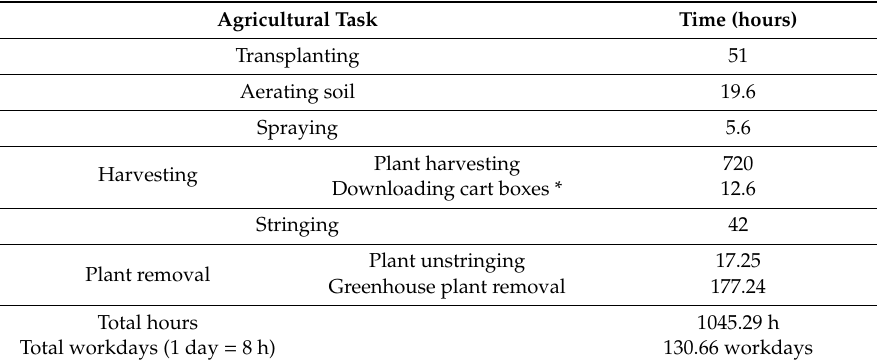
Table 9. Hours destined for each task and totals. Workdays